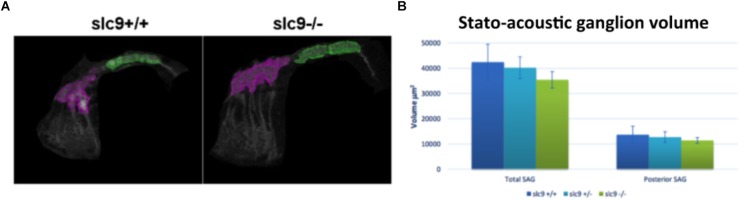
Stato-acoustic ganglion (SAG) characterization. (A) 3D reconstruction of the SAG in slc9a3r1 KI and their WT siblings (number of tested animals: slc9a3r1+/+
N = 3, slc9a3r1+/-
N = 6, slc9a3r1R180Q/R180Q
N = 6). The anterior part of the SAG is depicted in pink, while in green is indicated the posterior part which innervates the saccular macula and it is related to the auditory function. (B) The graph shows the total SAG volume (volume of the pink and green area) and the volume of the posterior SAG of slc9a3r1 animals. Although small differences (not statistically significant) no alterations were observed in the volume of the posterior stato-acoustic ganglion.